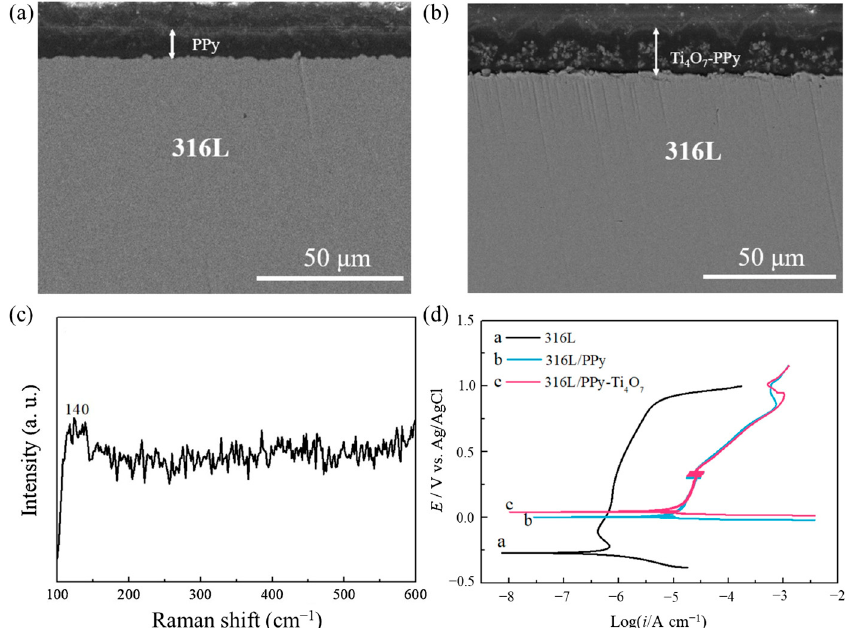
Figure 5. The cross-sectional morphologies of ( a ) PPy and ( b ) PPy-Ti 4 O 7 nanoparticles, ( c ) the Raman spectra curves of PPy-Ti 4 O 7 nanoparticles coating with 10% PPy, and ( d ) the potentiodynamic polarization curves of 316 L, 316 L/PPy, and 316 L/PPy-Ti 4 O 7 nanoparticles samples immersed in 0.1 M H 2 SO 4 /2 ppm HF solution at 25 °C for 1 h [93].